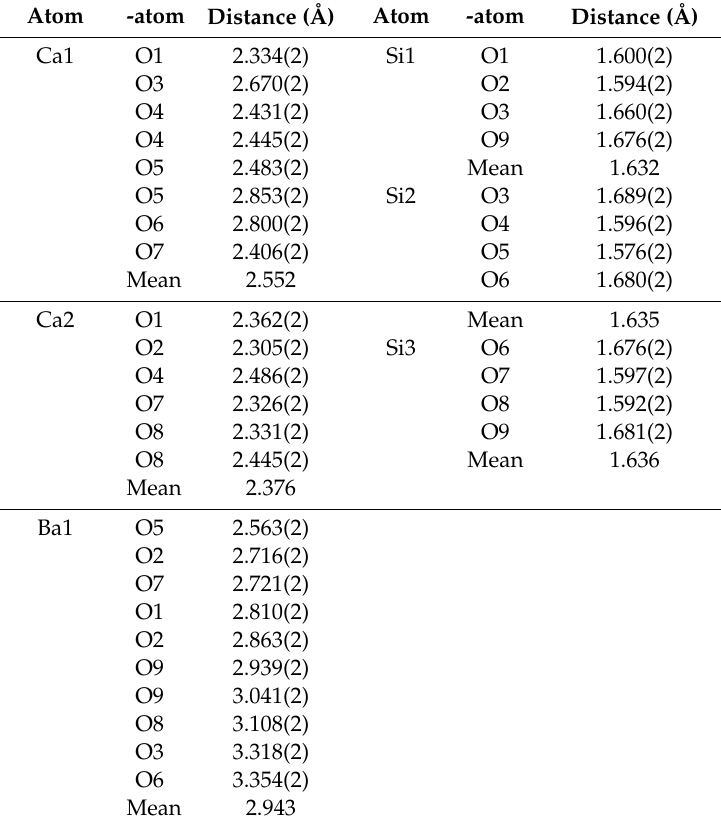
Table 4. Selected interatomic distances (Å) for